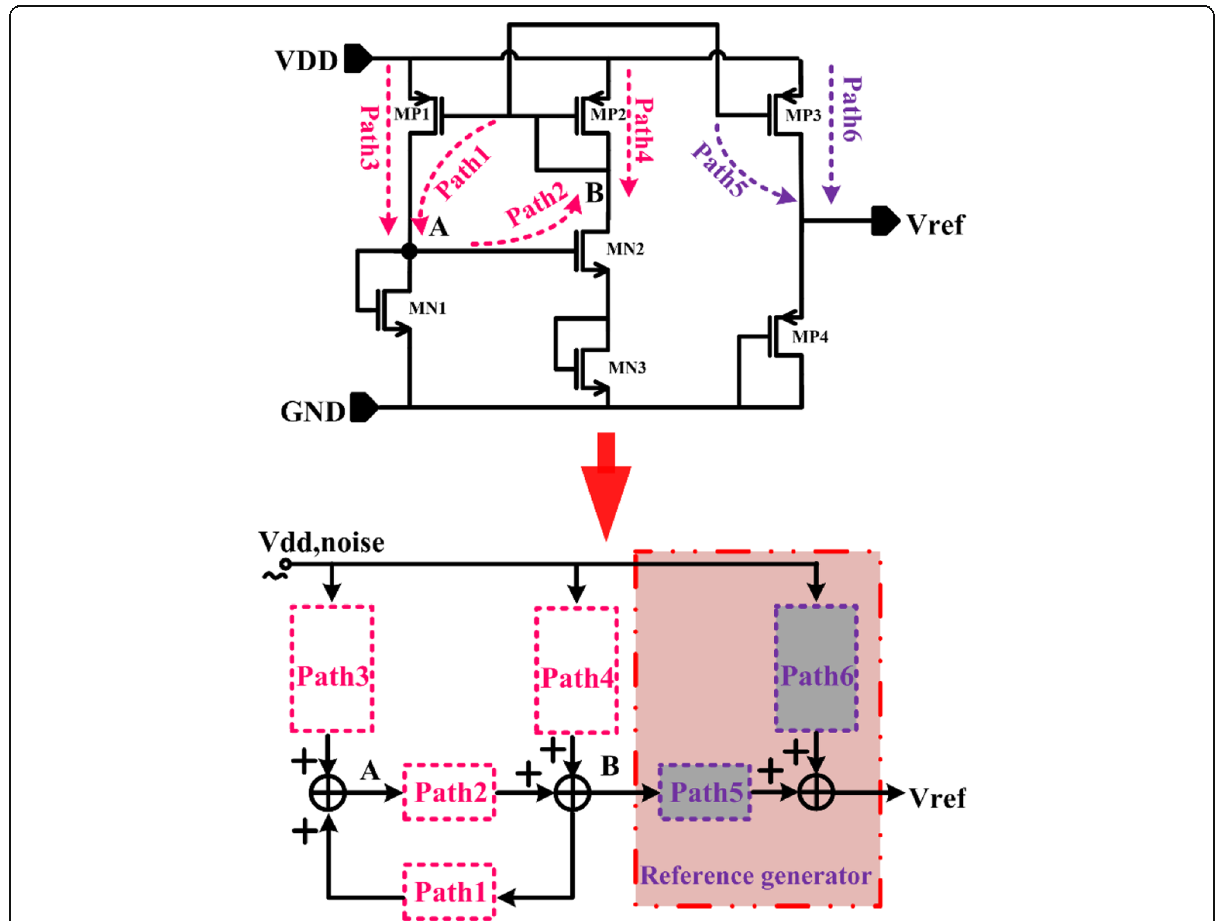
Fig. 2 The paths of supply voltage